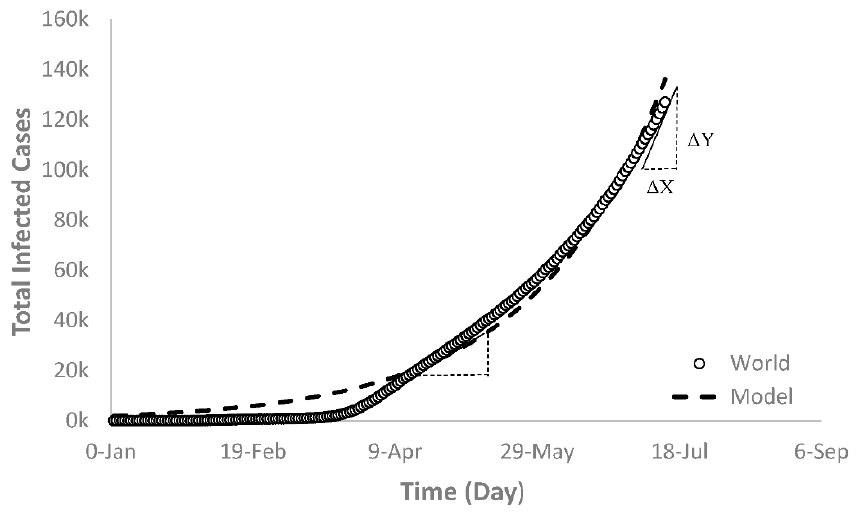
Figure 1. World total infected novel coronavirus (COVID-19) cases.